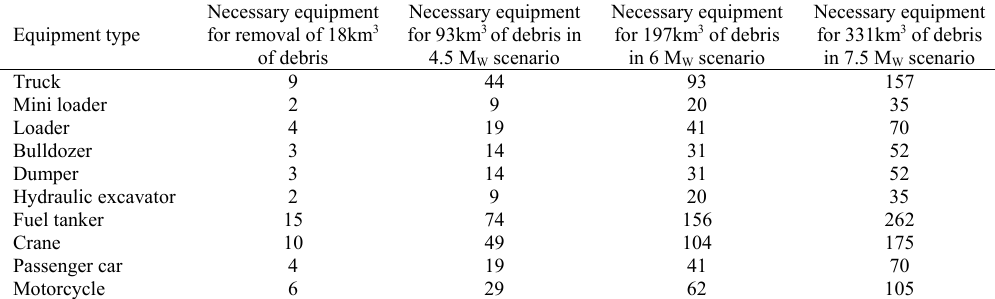
Table 4: Necessary equipment for debris removal in the Ray earthquake scenarios Equipment